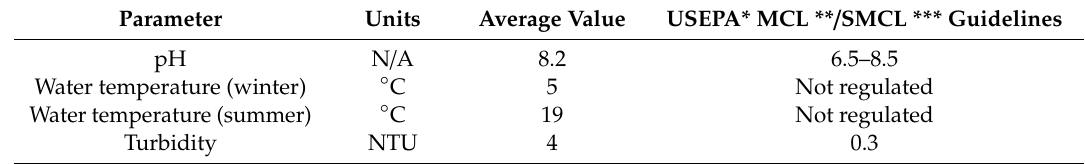
Table 1. Raw water quality report obtained from the drinking water treatment plant’s managers.